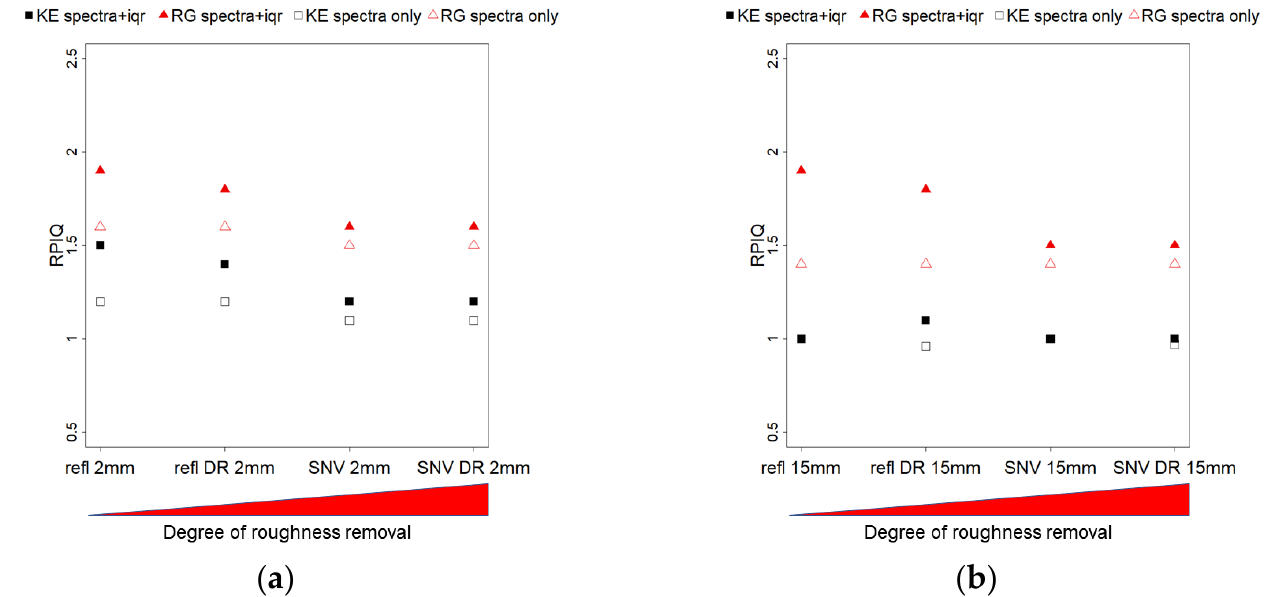
Figure 14. Validation of the PLSR models (using R 2 ) for the different data transformations, ordered by their degree of roughness removal, from left (none) to rigth (max). Black symbols depict KE models R 2 , while red symbols represent RG models R 2 . Solid symbols represent models based on spectral data + iqr, void symbols represent models based on spectra only. Panel ( a ) shows result for the 2 mm scale, panel ( b ) results for the 15 mm scale.